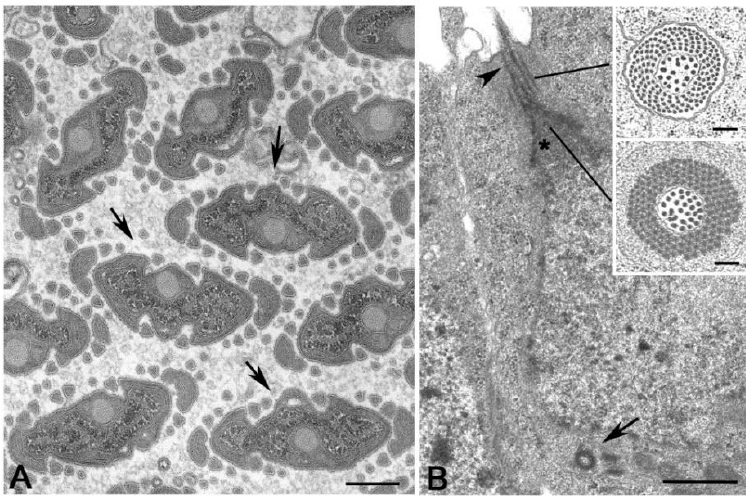
Figure 9. Aflagellate sperm. ( A ) Cross section of aflagellate sperm (arrows) in the homopteran aleyrodid Bemisia . ( B ) Spermatid of the archaeococcidae Matsucoccus showing a pair of orthogonal centrioles (arrow) and a peripheral bundle of microtubules (arrowhead) emerging from a cluster of dense material (asterisk); insets are cross sections at different levels within the microtubule bundle. Bars: A,B, 1 mm; insets, 200 nm.